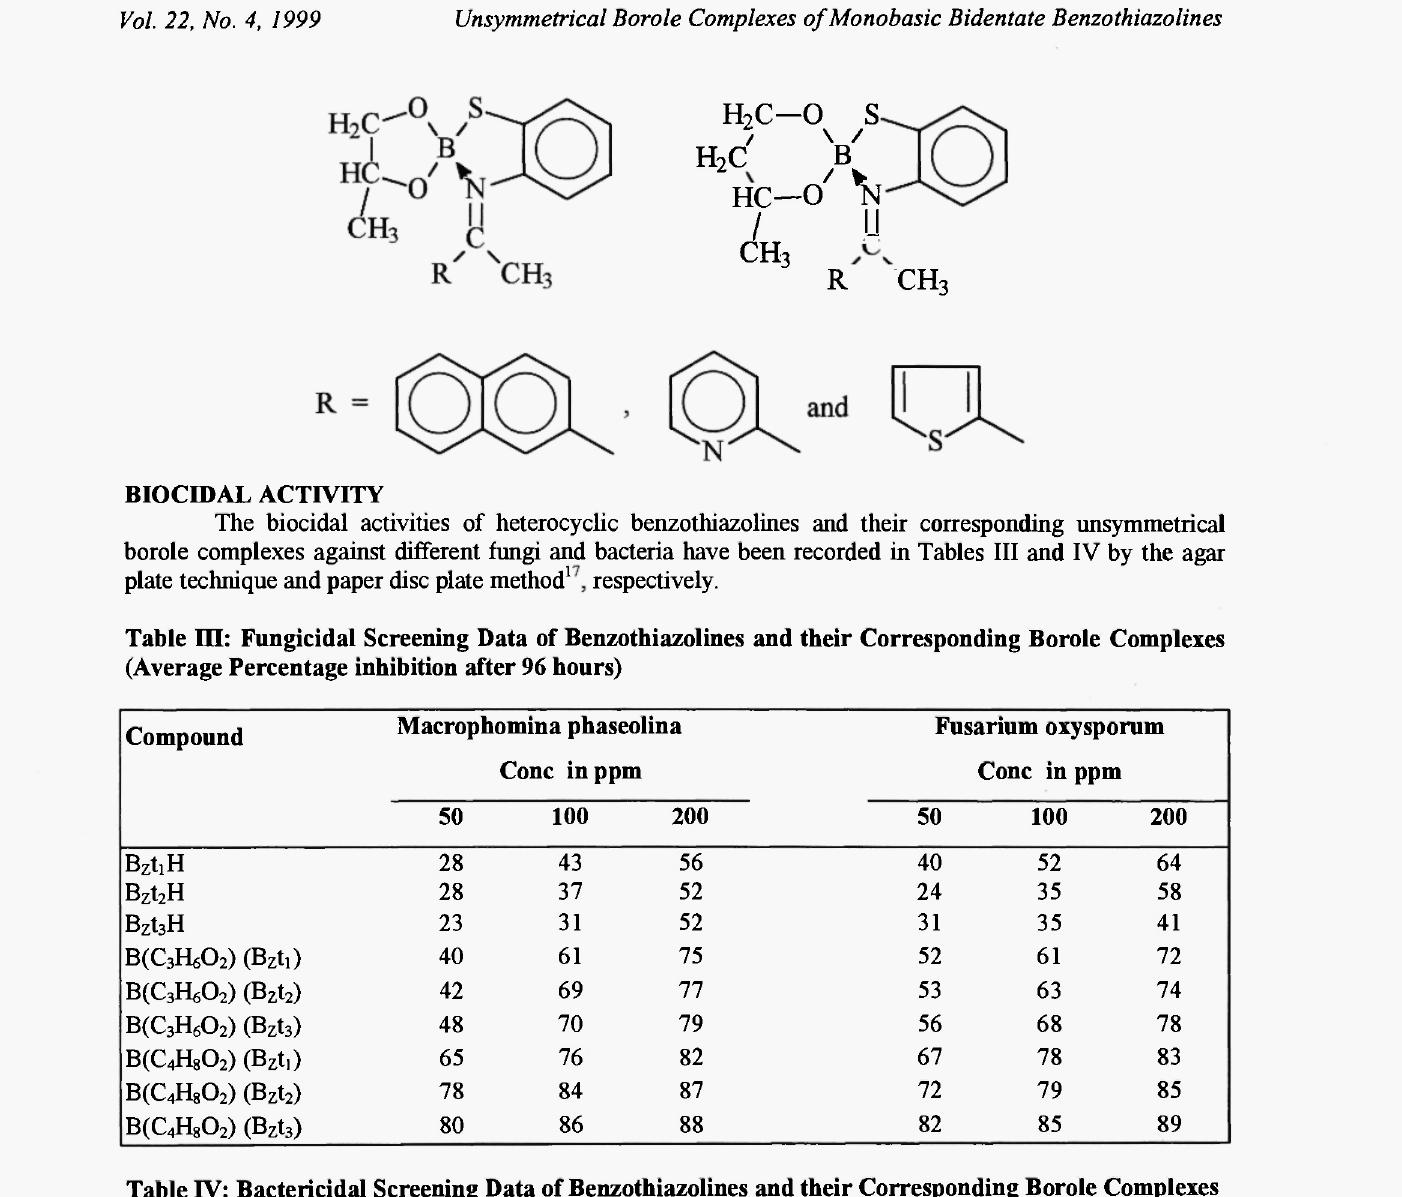
Table IV: Bactericidal Screening Data of Benzothiazolines and their Corresponding Borole Complexes Compound